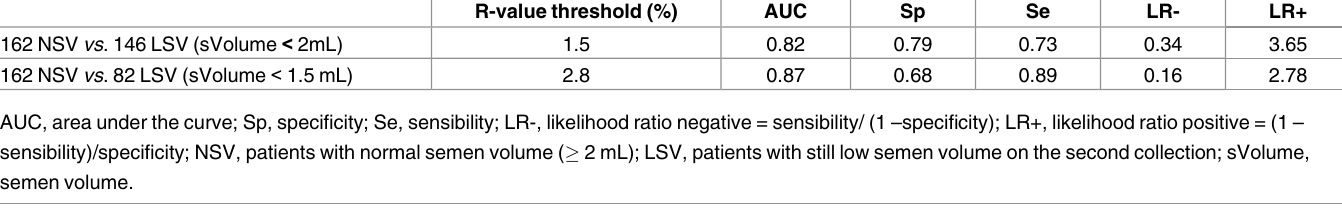
of LSV patients with an R value (cid:21) 7.1% was lower (p = 0.006 and p < 0.001) than semen vol- ume of LSV patients in the two other classes of R-value. Second, the CART algorithm applied to the population (n = 244) of 162 NSV patients ( (cid:21) 2 mL) and 82 LSV patients ( < 1.5mL) determined two threshold values for R: 2.8% and 8.3% ( S1 Data and S1 Fig ). Table 2. Optimal R-value thresholds obtained from ROC plot for the 162 patients with normal semen volume (NSV; (cid:21) 2 mL) versus 146 patients with observed low semen volume ( < 2 mL) and 82 patients with observed low semen volume ( < 1.5 mL). R-value threshold (%) AUC Sp